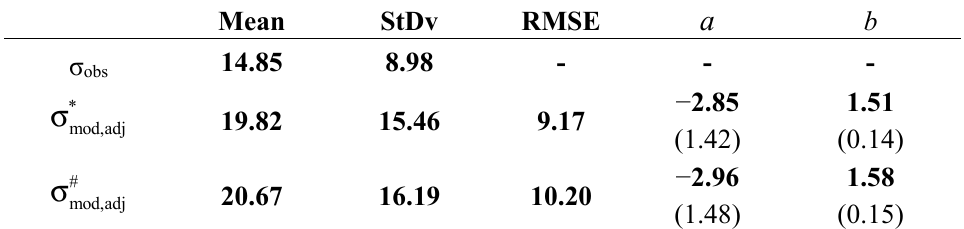
Table 3. The same as Table 2 (middle part) except for the scattering coefficients * σ (bottom row) calculated for size distributions adjusted with (middle row) and # mod,adj